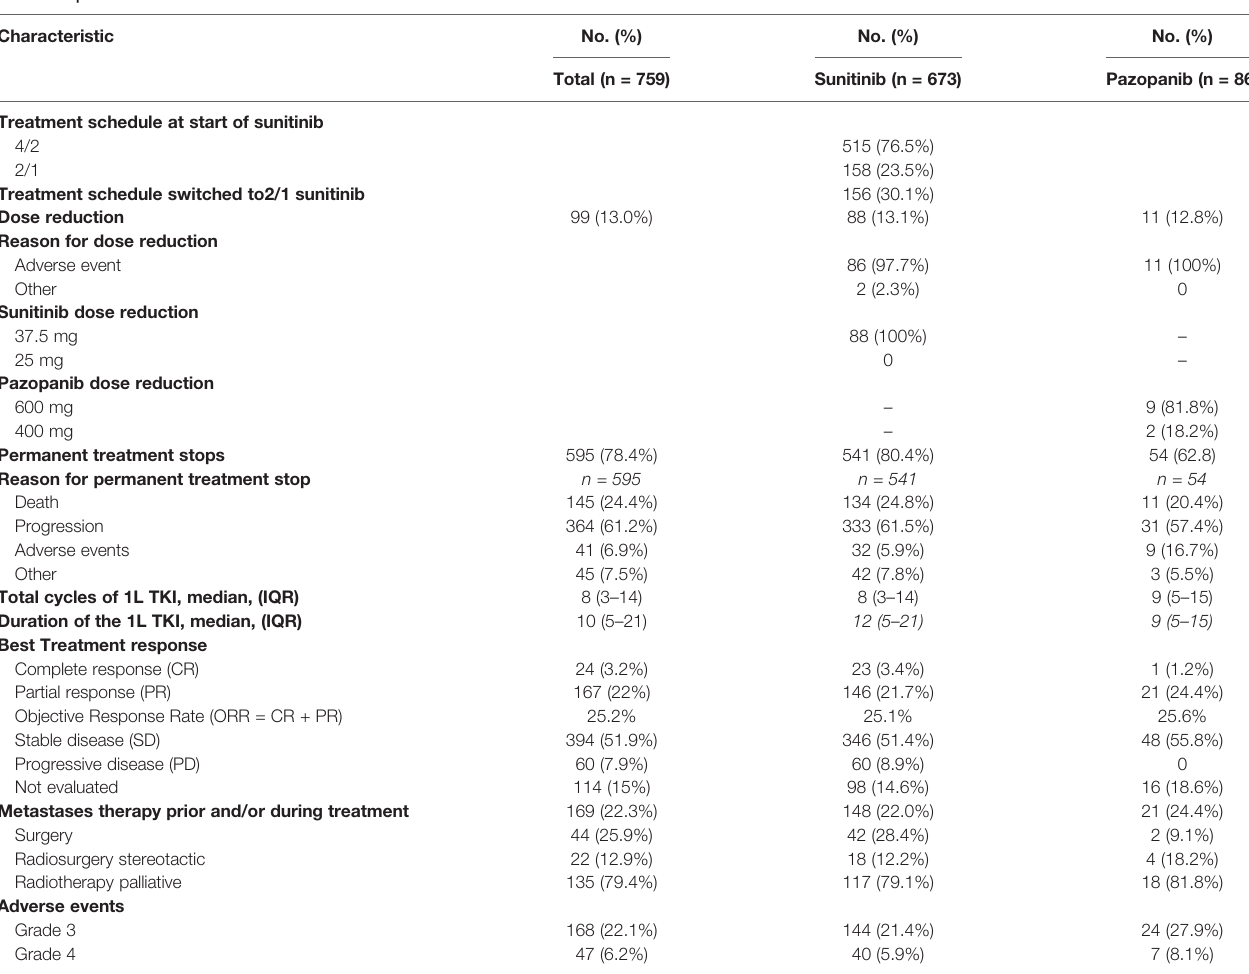
TABLE 2 | First-line TKI treatment